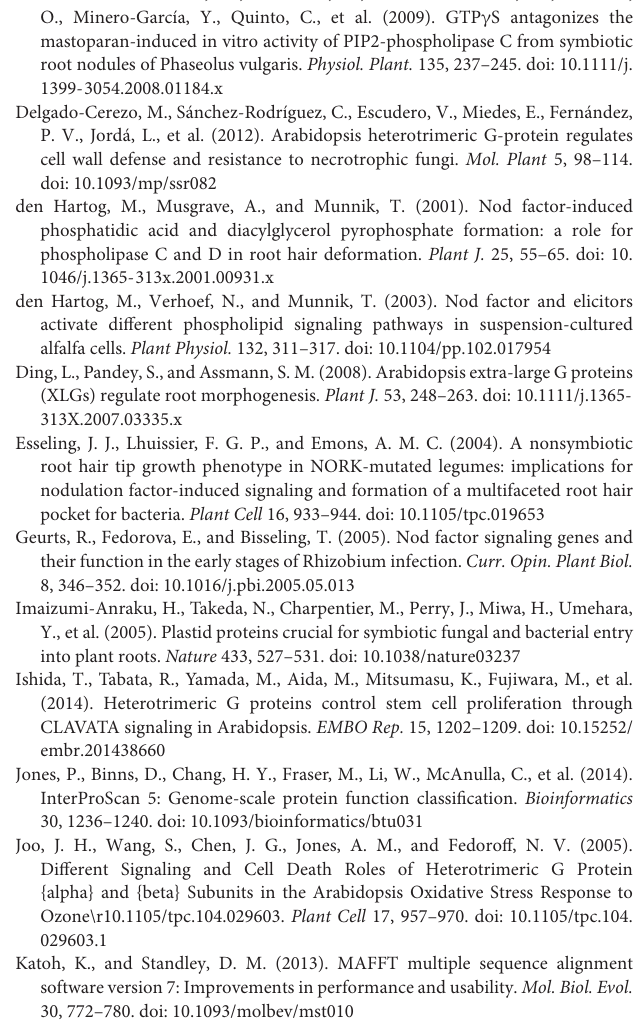
Supplementary Figure 5 | Bar plots represent CPM values of MtPLC genes expression in M. truncatula during early stages of symbiosis development based on Gene expression data from GSE133612 project (Schiessl et al., 2019). Supplementary Figure 6 | Bar plots represent CPM values of MtPLD genes expression in M. truncatula during early stages of symbiosis development based on Gene expression data from GSE133612 project (Schiessl et al., 2019). Supplementary Table 1 | List of primers used in this study. Supplementary Table 2 | The genome of M. truncatula encodes nine PLC and fifteen PLD genes. Analysis of transcriptomic datasets for M. truncatula roots inoculated with rhizobia, or treated with Nod factors (van Zeijl et al., 2015; Damiani et al., 2016; Schiessl et al., 2019), revealed that the expression of MtPLC1 (Medtr3g070560) (Damiani et al., 2016; Schiessl et al., 2019) and MtPLD1 (Medtr4g010650) increased at the early stages of symbiosis development ( Supplementary Figures 4 , 5 ). Genes in P. sativum were selected based on homology to the orthologs of M. truncatula and included one